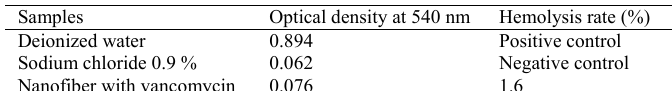
Table 1. Hemolysis ratio of the samples.